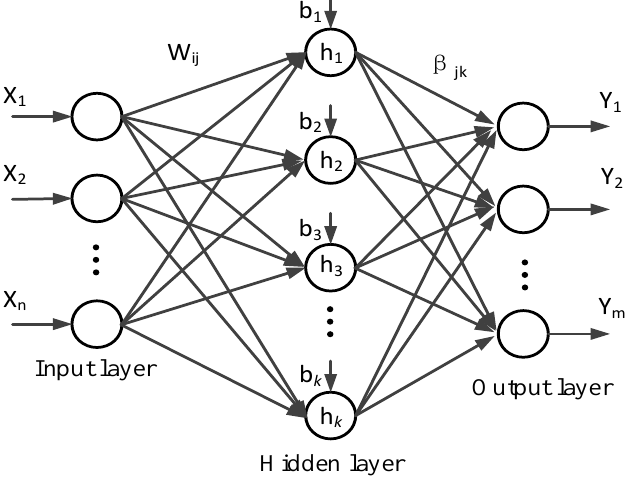
Figure 3. Illustration of single - layer feedforward neural network.